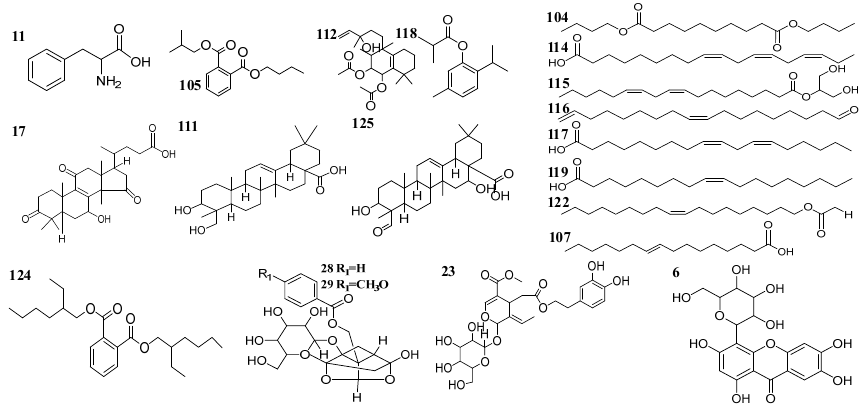
Figure 2. Chemical structures of compounds identified in MCG and CG.